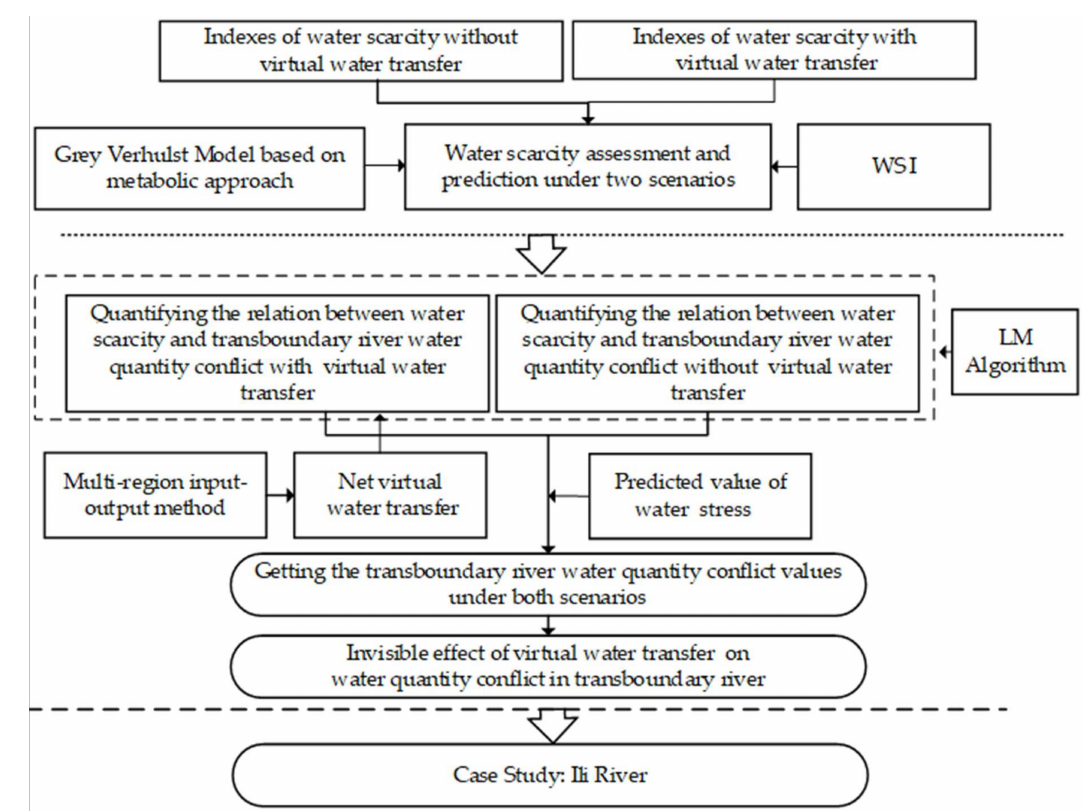
Figure 1. Research